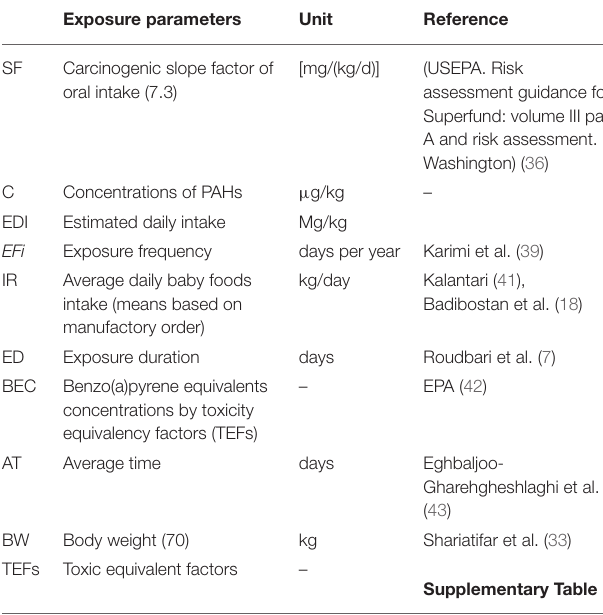
TABLE 2 | Parameters used in the present study for health exposure assessment in baby foods. Exposure